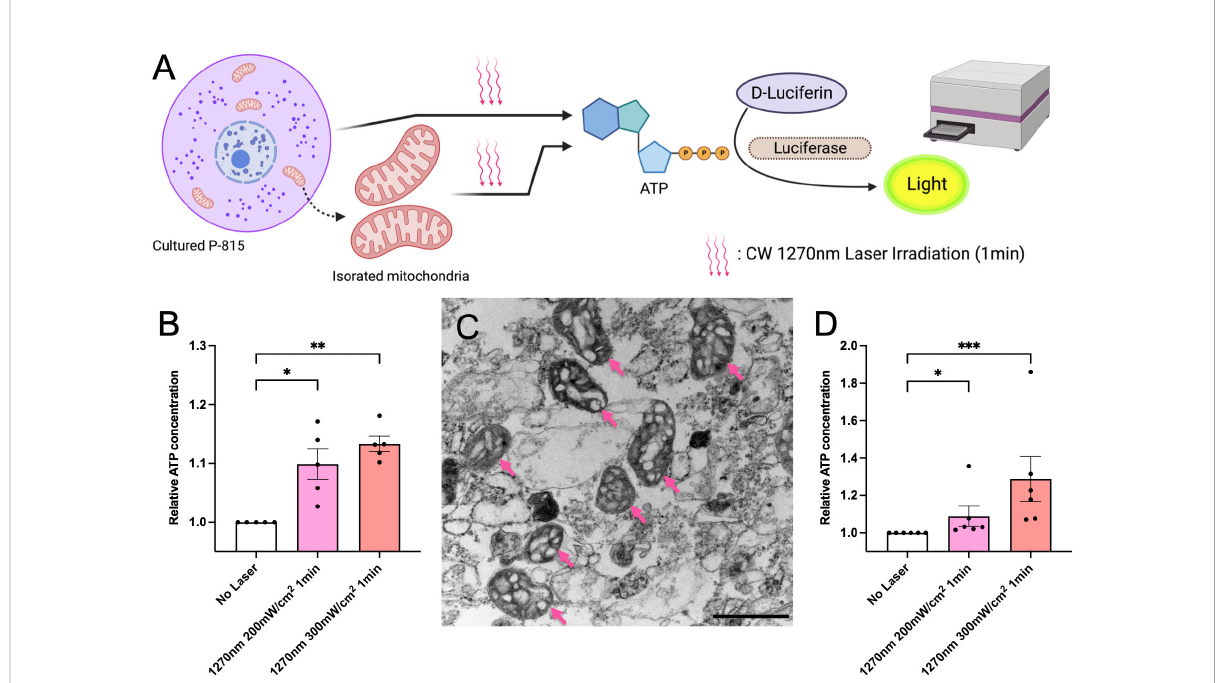
FIGURE 3 ATP generationinduced by the near-infrared (NIR)laser treatment ofcultured mast cells. (A) Release ofATP by the NIR lasertreatment was assesssed usingthe luciferase luciferin reaction. (B) Fold increases in luminescence intensity using the luciferase reaction in cultured P-815 in vitro . (C) Isolated mitochondria werecon fi rmed usingelectron microscopy (arrow); the scalebar represents 0.1 m m. (D) Fold increases in luminescenceintensity using the luciferase reactionin mitochondria isolated fromcultured P-815. Kruskal – Wallis test with Dunn ’ s multiple comparisons test (No Laser vs. 200 mW/ cm 2 , 300 mW/cm 2 , * p <0.05,** p <0.01,***p<0.001, B: n = 5 per group, D: n = 6 per group), Error barsshow mean ±